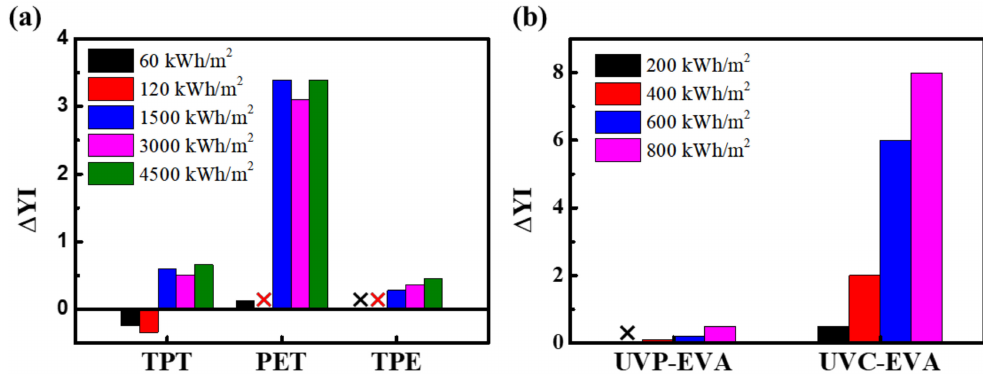
Figure 15. Change in yellowness index ( ∆ YI) of ( a ) backsheet and ( b ) encapsulant after UV- light